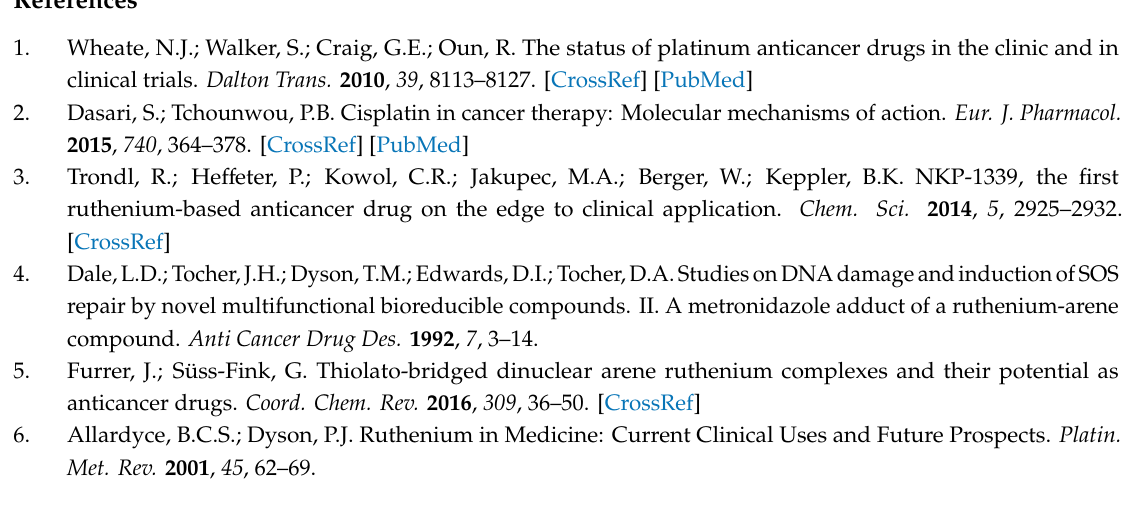
untreated; Figure S13: TOCSY spectra of A2780cisR cells treated with a high dose (0.03 µ M) of DiRu-1; Figure S14: Percental change in the aliphatic buckets in A2780cisR cells: complete including unidentified buckets; Figure S15: Percental change in the aliphatic buckets in A2780 cells: complete including unidentified buckets; Figure S16: Percental change in the aliphatic buckets in HEK-293 cells: complete including unidentified buckets; Figure S17: Percental change in the aromatic buckets in A2780cisR cells; Figure S18: Percental change in the aromatic buckets in A2780 cells; Figure S19: Percental change in the aromatic buckets in HEK-293 cells; Figure S20: Comparison of bucket means for aliphatic region of A2780cisR; Figure S21: Comparison of bucket means for aliphatic region of A2780; Figure S22: Comparison of bucket means for aliphatic region of HEK-293; Figure S23: Comparison of bucket means for aromatic region of A2780cisR; Figure S24: Comparison of bucket means for aromatic region of A2780; and Figure S25: Comparison of bucket means for aromatic region of